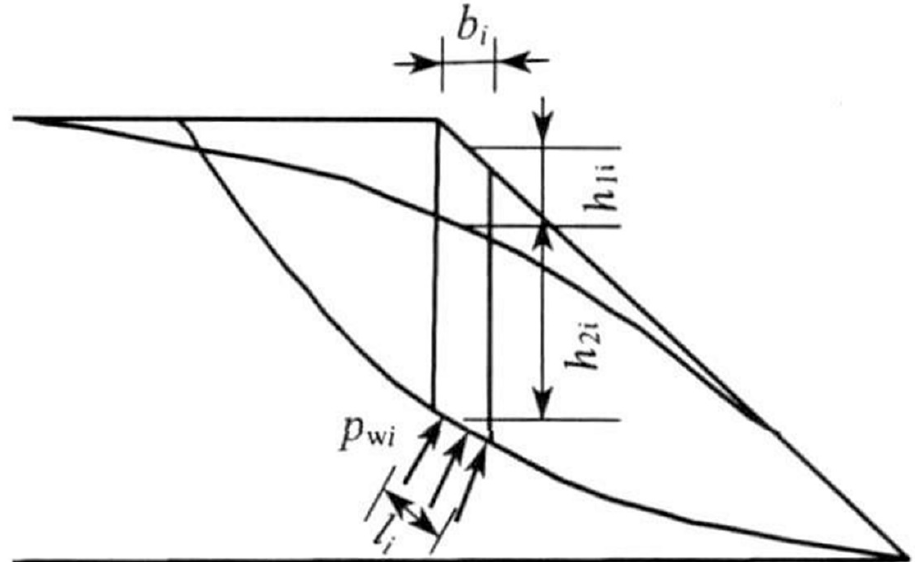
Figure 1. Sketch map for calculation of safety factor.